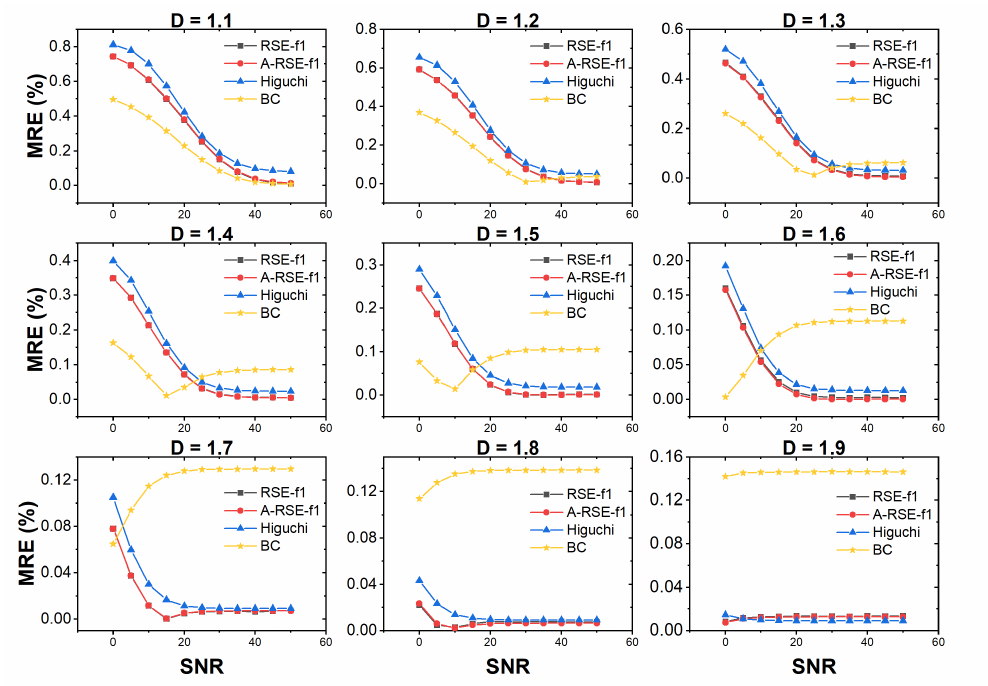
Figure 8. The comparision of anti-noise performances of RSE-f1, A-RSE-f1 Higuchi, and BC algo- rithms under different D i and signal-noise-ratio (SNR)